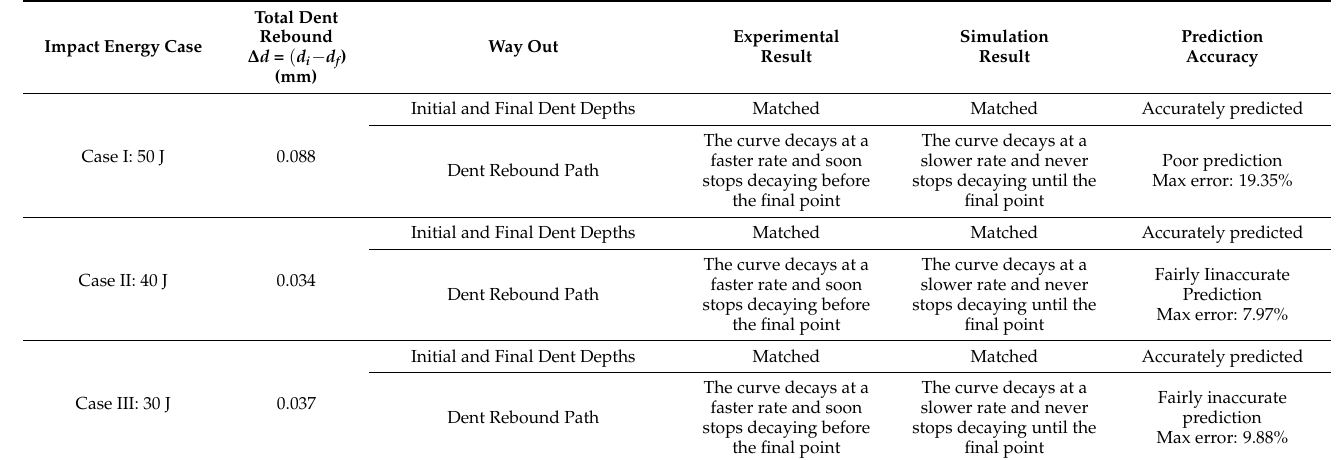
Table 10. Comparison between experimental and simulation